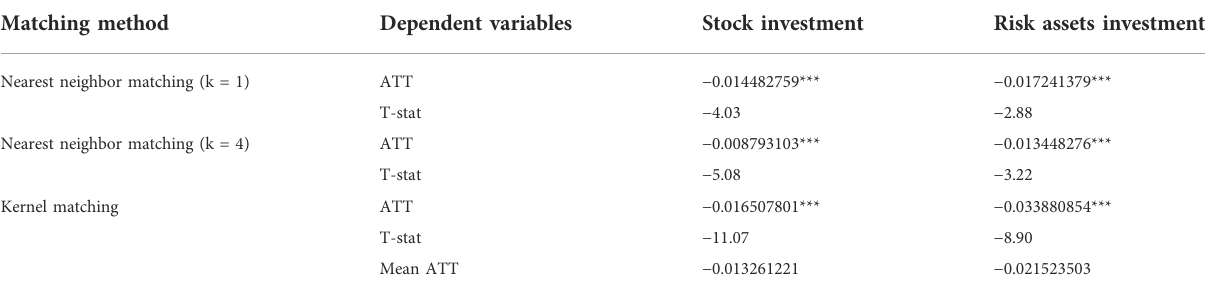
TABLE 5 Comparisons of average treatment effect